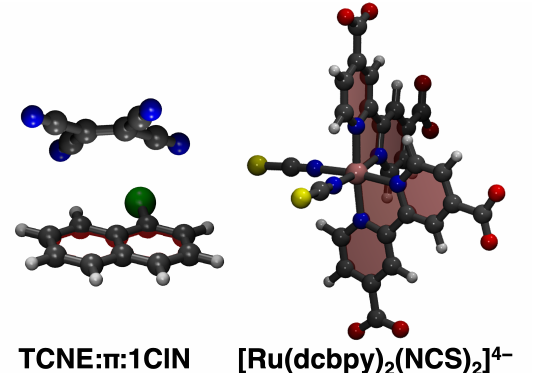
Figure 1. Case studies investigated in the present work. The TCNE: π :1ClN non-covalent dimer and Ru(II) complex ([Ru(dcbpy) 2 (NCS) 2 ] 4 − or “N3 4 − ”, dcbpy = 4,4 (cid:48) -dicarboxy-2,2 (cid:48) -bipyridine) are presented from left to right, respectively (Carbon is in gray, Hydrogen in white, Chlorine in green, Sulphur in yellow, Oxygen in red, Nitrogen in blue, Ruthenium in